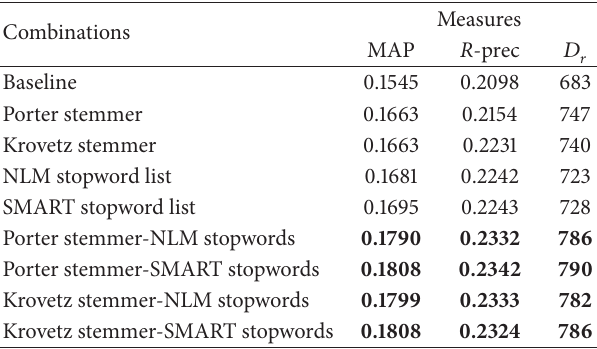
Table 4: Accuracy of query search using different stemming functions and stopword lists in Cystic Fibrosis. Evaluation measures used are MAP (mean average precision), R -prec ( R precision), and 𝐷 𝑟 (number of relevant documents